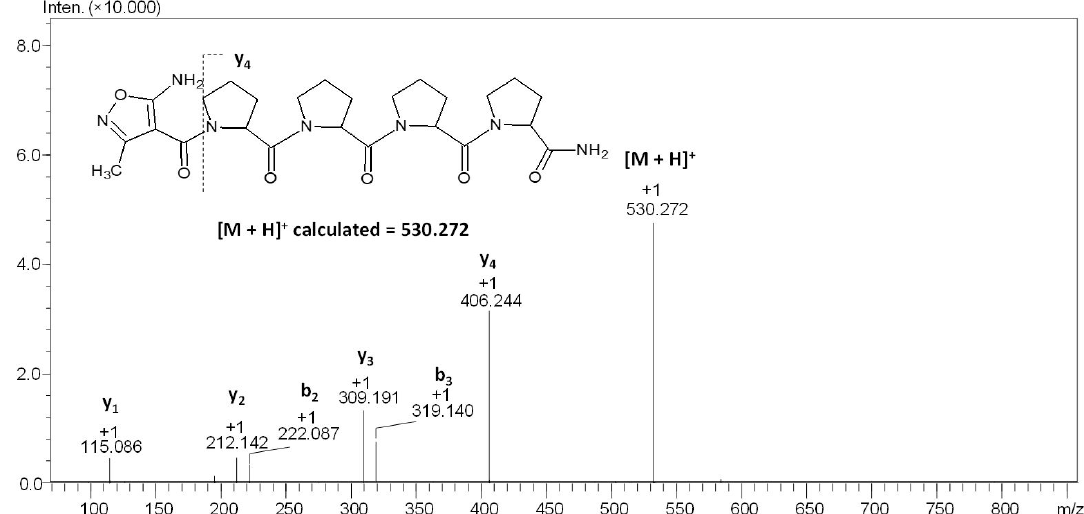
Figure 7. ESI-MS/MS spectrum of compound 3 . Parent ion m / z 530.272, collision energy 20–40